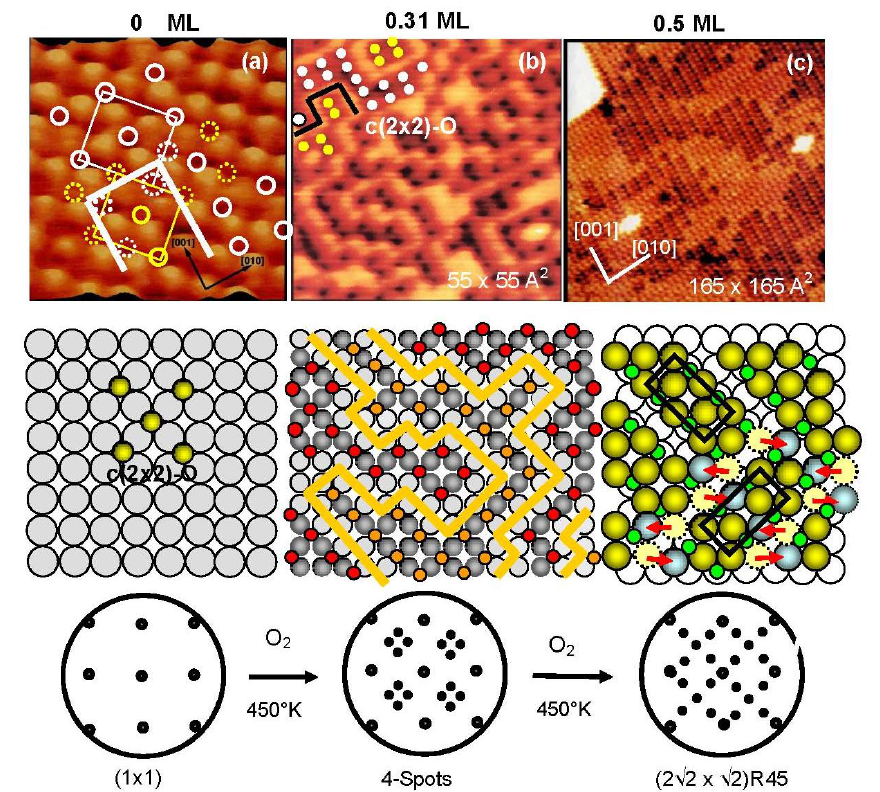
Cu(100); ( b ) Four spots surface at 0.31 mL oxygen coverage (exposed to O (10 -7 Torr × 80 s) attained at ca. 450 °K ), and ( c ) (2√2 × √2)R45° surface at ca. 0.5 ML coverage, and their model structures. Cu-atom missing ditches of the (2√2 × √2)R45° surface can change the orientation of a ditch from the [001] to [010] or vice versa by shifting Cu atoms to an equivalent neighbor sites